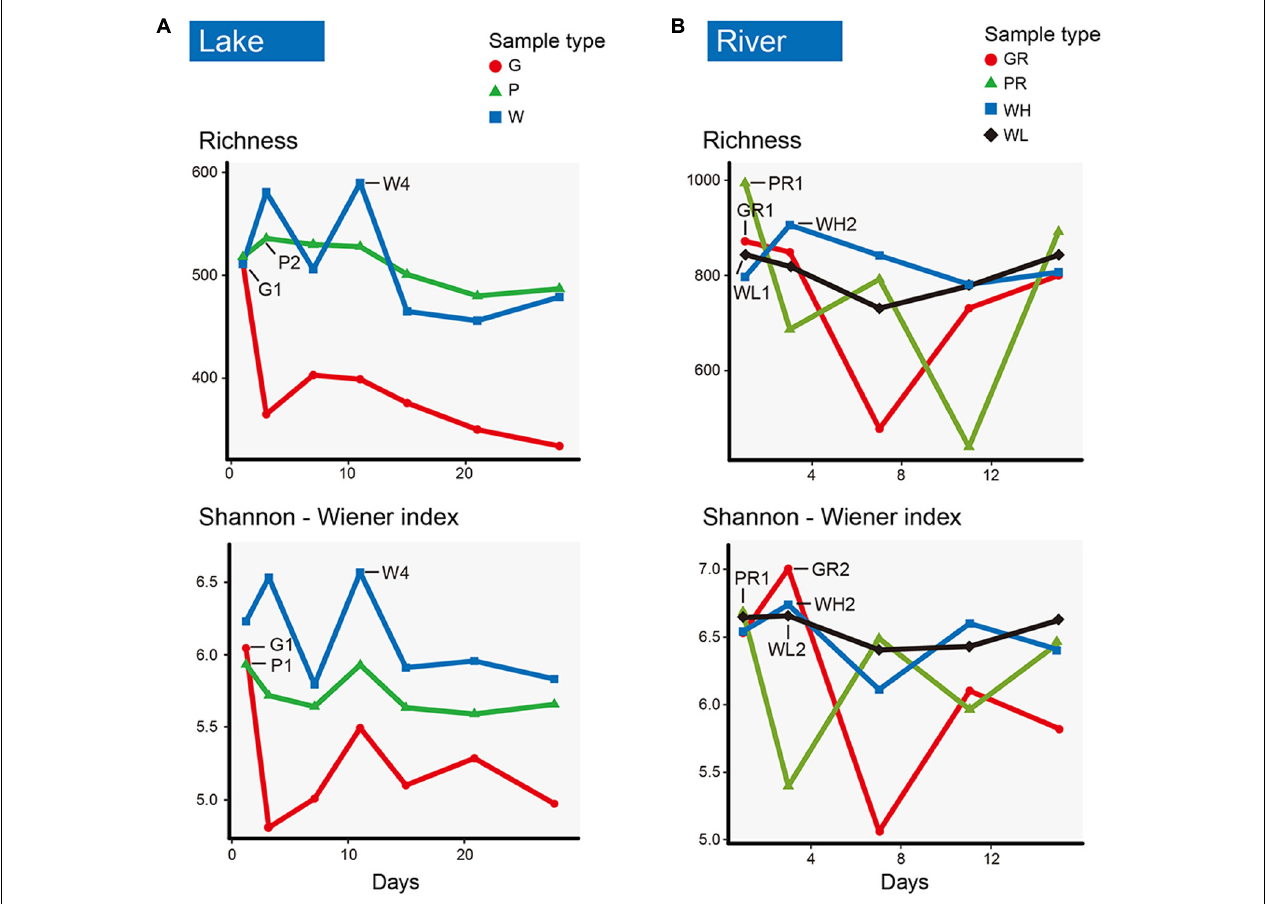
FIGURE 4 | Richness and Shannon–Wiener index of microeukaryotic communities from glass slides (G, red), PFUs (P, green), and water columns (W, blue) in lake (A) across sampling time (1st, 3rd, 7th, 11th, 15th, 21th, 28th days). Richness and Shannon–Wiener index of glass slides (GR, red), PFUs (PR, green), water columns (WH, blue) at high tide, and water columns at low tide (WL, black) in river (B) across sampling time (1st, 3rd, 7th, 11th, 15th